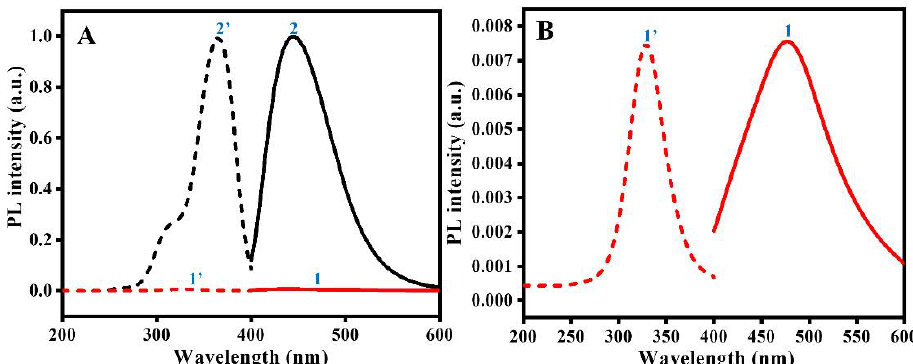
Figure 2. ( A ) Excitation fluorescence spectra (1′, 2′) and emission fluorescence spectra (1, 2) of the NPCDs (2′, 2) and NPCD/AgNP nanocomposites (1′, 1), ( B ) magnified excitation and emission fluorescence spectra of the NPCD/AgNP nanocomposites.